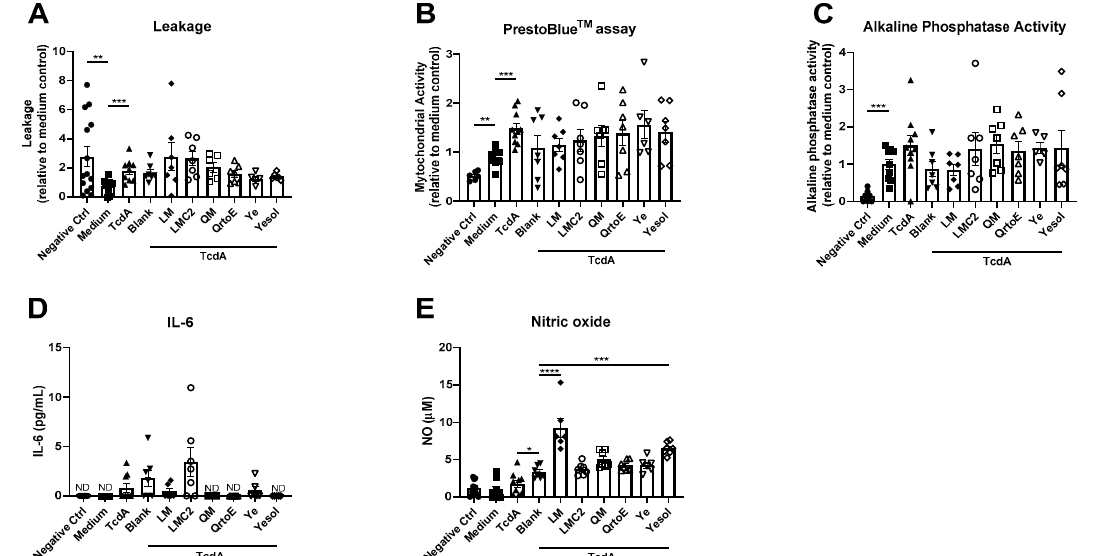
test (compared to blank), * p < 0.05, ** p < 0.005, and *** p < 0.001. ND, not detectable.